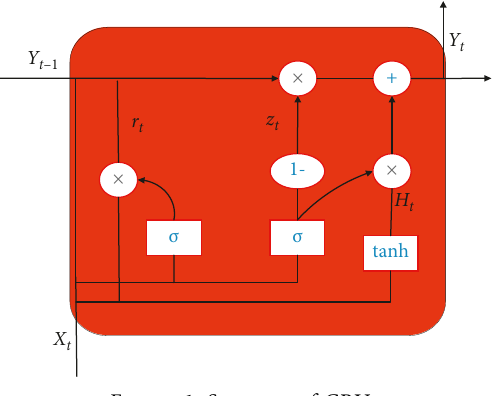
Figure 1: Structure of